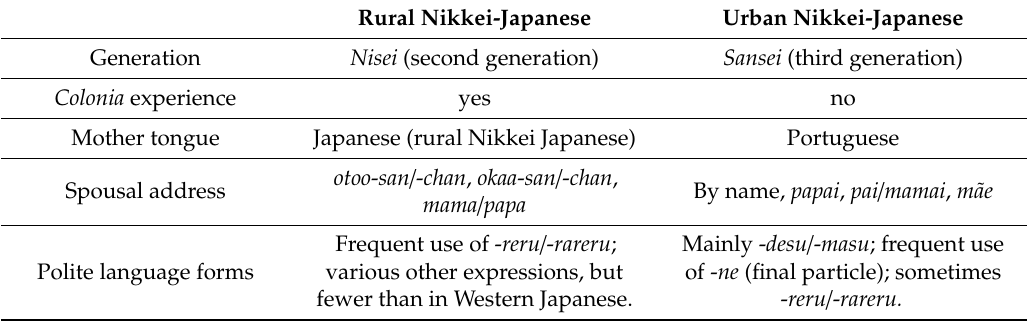
Table 1. Comparison of correlation categories across rural and urban Nikkei